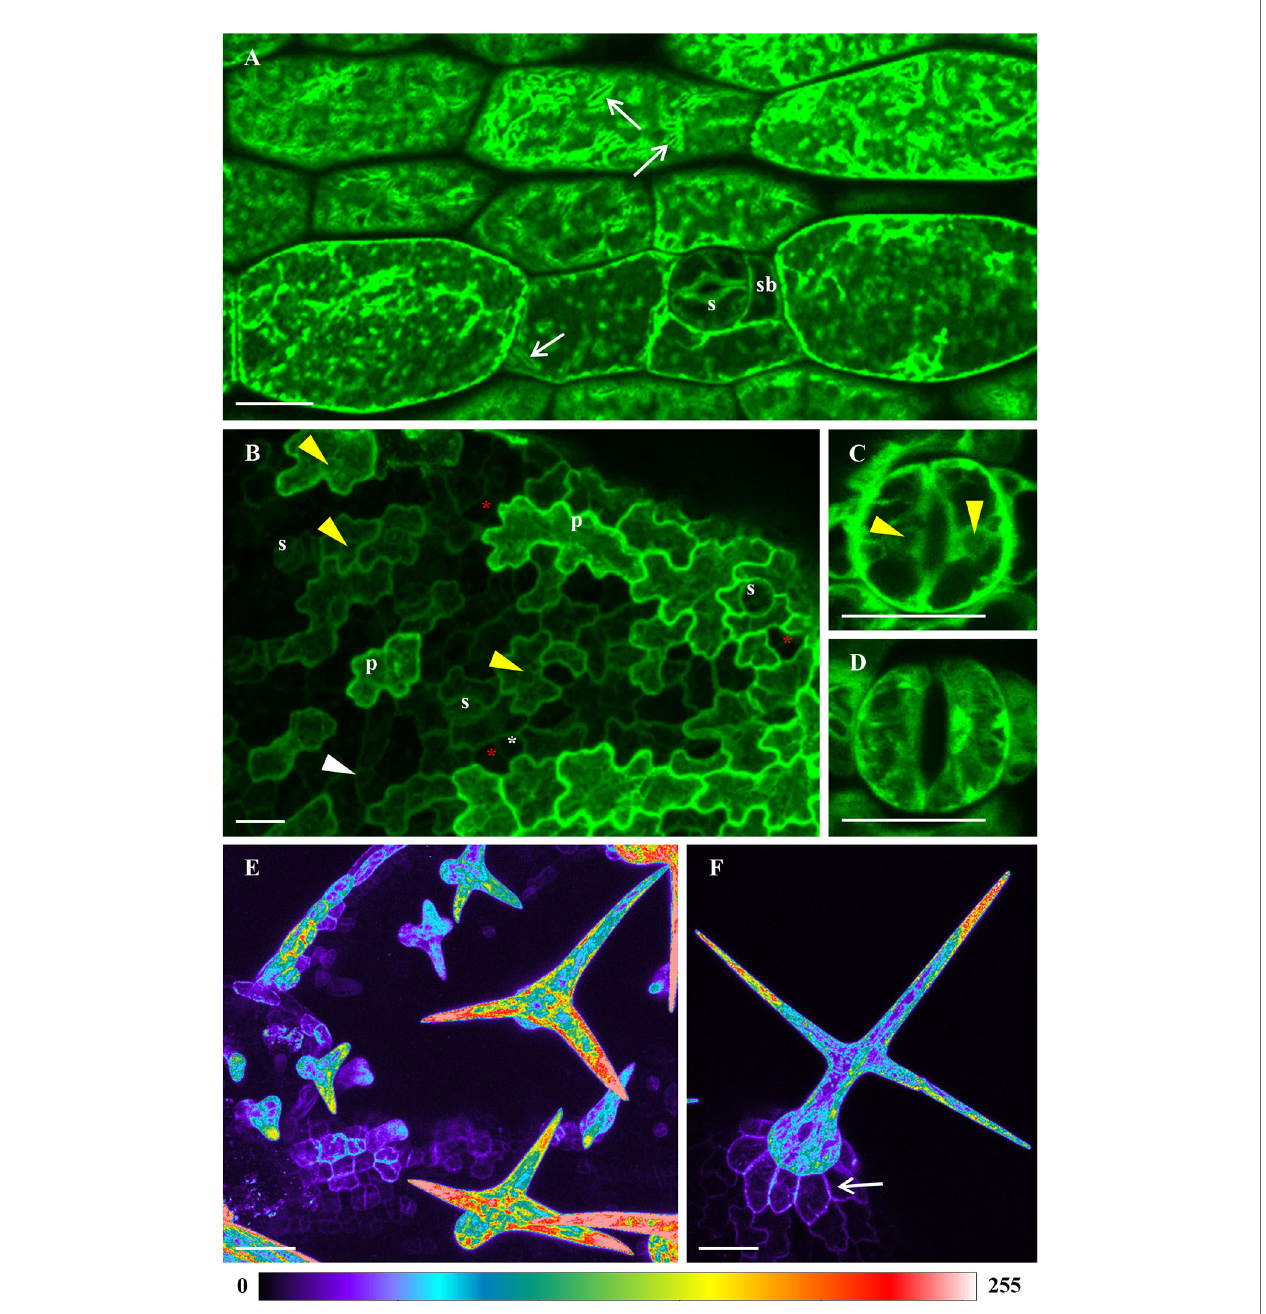
FIGURE 1 | Tissue- and cell-speci fi c localization of ANN1-GFP in different aerial organs of A. thaliana seedlings stably expressing proANN1::ANN1:GFP construct using confocal laser scanning microscopy (CLSM). (A) Expression of ANN1-GFP in hypocotyl epidermal cells showing its localization in the cell cortex, cytoplasmic strands, and in areas around membranous compartments resembling ER bodies (arrows). ANN1-GFP expression delineated cell cortex in stomata guard cells (s) and subsidiary cells (sb). (B) Unequal distribution of ANN1-GFP in epidermal cells of developing fi rst true leaf. Prominent production of ANN1-GFP was evident in expanding pavement cells (p), whereas it was almost absent in stomatal precursor cells: meristemoid mother cells (red asterisks), meristemoids (white arrowhead) and guard mother cells (white asterisks). (C, D) Distribution of ANN1-GFP within radially organized arrays of cytoplasmic strands in leaf stomata guard cells presented in the medial plane (C) and in the cortical plane (D) . Note the absence of ANN1-GFP fl uorescence in nuclei indicated by yellow arrowheads in (B, C) . (E, F) Color-coded images of ANN1-GFP localization in different developmental stages of trichomes. Note the tip-focused accumulation of ANN1-GFP in trichomes (E, F) and its lower abundance in basal cells of developed trichome indicated by an arrow in (F) . Scale bars = 20 m